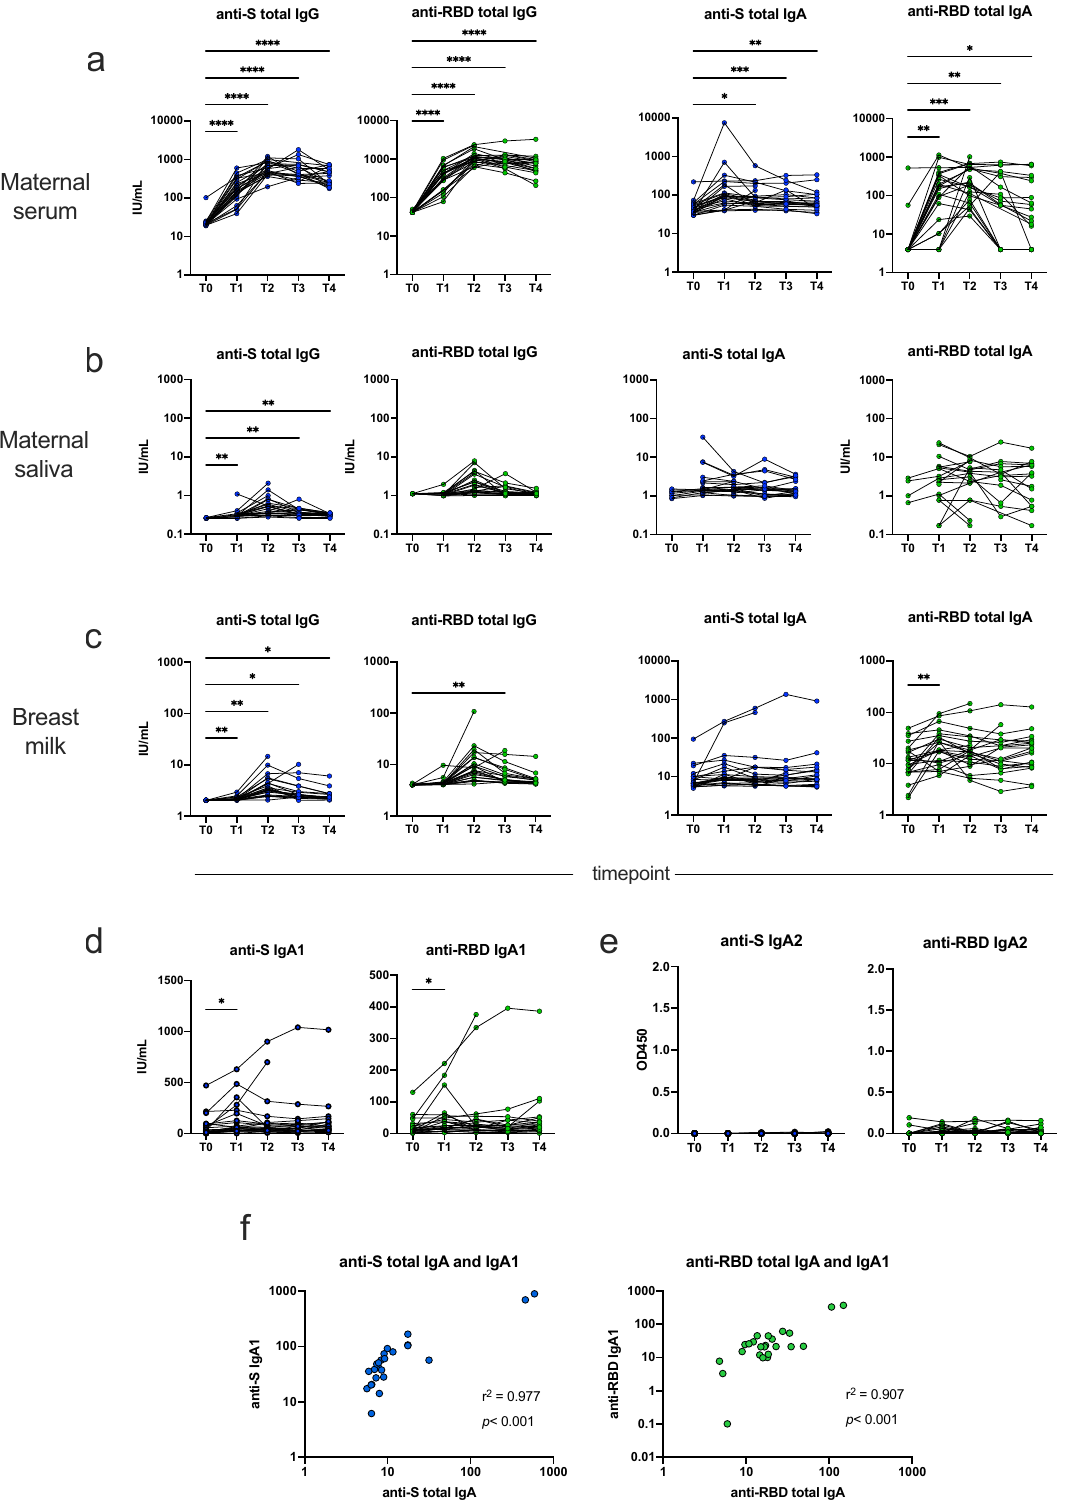
Fig. 2 Antibody concentrations in maternal samples up to 90 days after receipt of BNT162b2 vaccine during lactation. a – c Antibody concentrations in maternal samples, after vaccination with BNT162b2 vaccine ( n = 24). Subjects received the fi rst dose at T0, and the second dose 21 days later, at T1. Then samples were collected every 30 ± 1 days until 90 ± 1 days after the second dose (T4). If there were no missing samples, P values were calculated by repeated-measures ANOVA with Dunnett ’ s correction for multiple comparison. In case of randomly missing samples, a mixed-effect model using the maximum likelihood method was applied. ****<0.001, ***<0.005, **<0.01, *<0.05. d , e titers of anti-SARS-CoV-2 IgA1 and IgA2 in breast milk at different timepoints. Statistic methodology as reported in ( a – c ). f Correlation between breast milk total anti-SARS-CoV-2 IgA and IgA1 concentration at 30 ± 1 days after vaccination